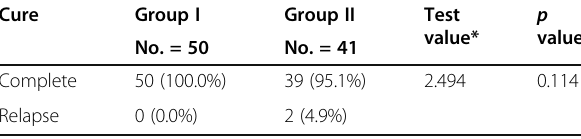
Table 1 Comparison between group I (control group) and group II (case group) regarding cure rate after treatment Cure Group I